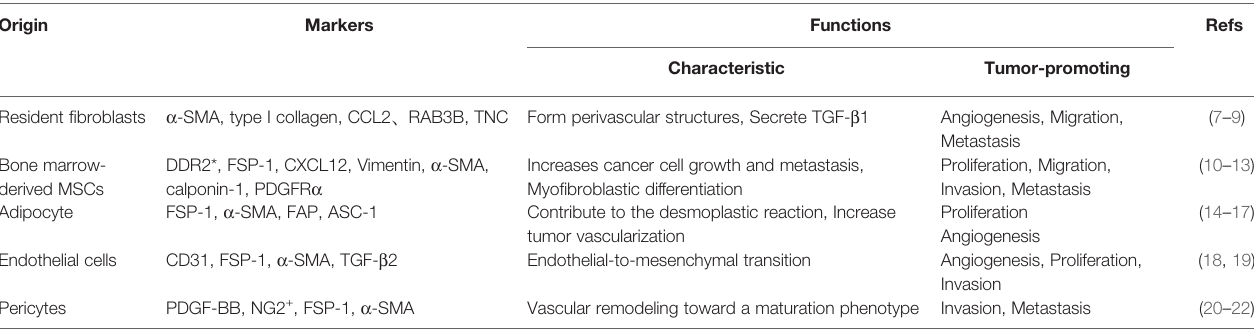
TABLE 1 | The heterogeneity of CAF ’ s